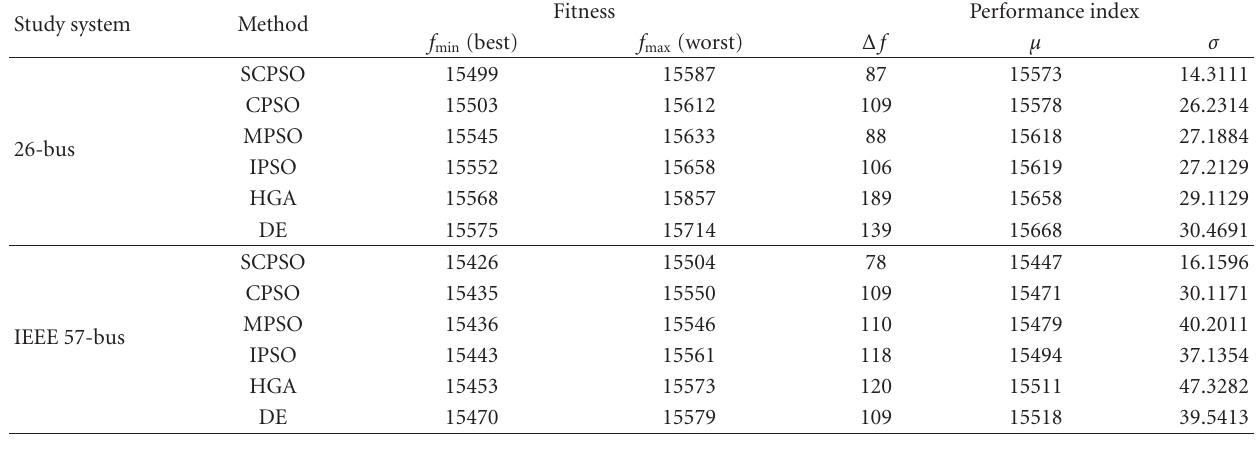
Table 5: Comparisons of four methods in two study Systems.